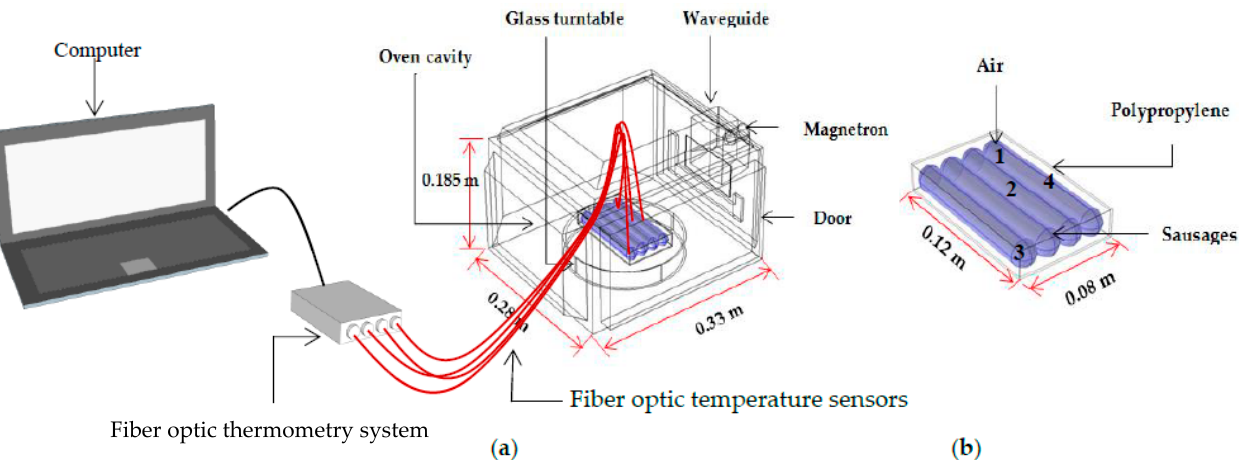
Figure 1. The ( a ) experimental setup of temperature measurement in household microwave and ( b ) geometry of sausages.